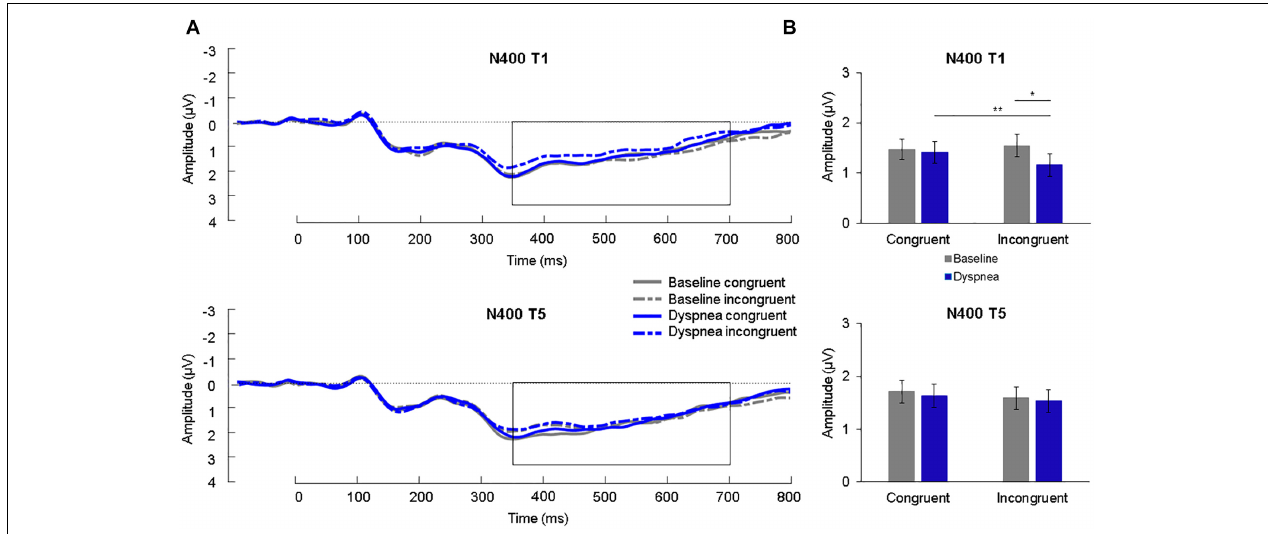
FIGURE 5 | (A) Grand average waveforms ( µ V) during each condition at centro-parietal sites for congruent and incongruent stimuli for T1 (upper panel) and T5 (lower panel). The N400 is highlighted from 350 to 700 ms. (B) Mean ( SE ) amplitudes ( µ V) during each condition for the N400 for congruent and incongruent stimuli for T1 (upper panel) and T5 (lower panel). ∗ p < 0.05, ∗∗ p <